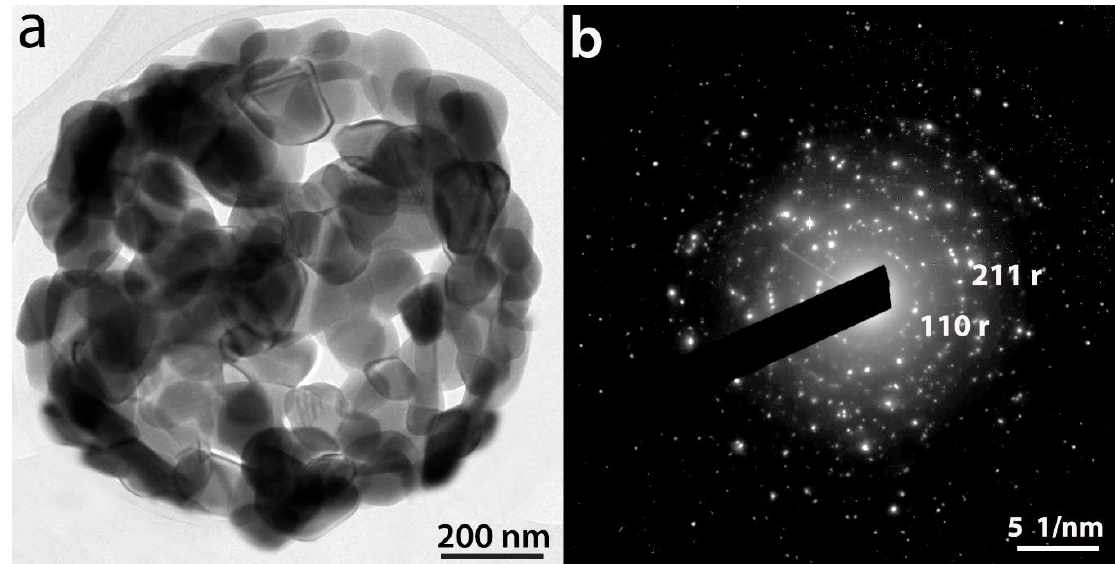
Figure 11. Representative TEM picture of a 1.70%_1000 HS ( a ) and SAED pattern corresponding to the HS is shown in ( b ).